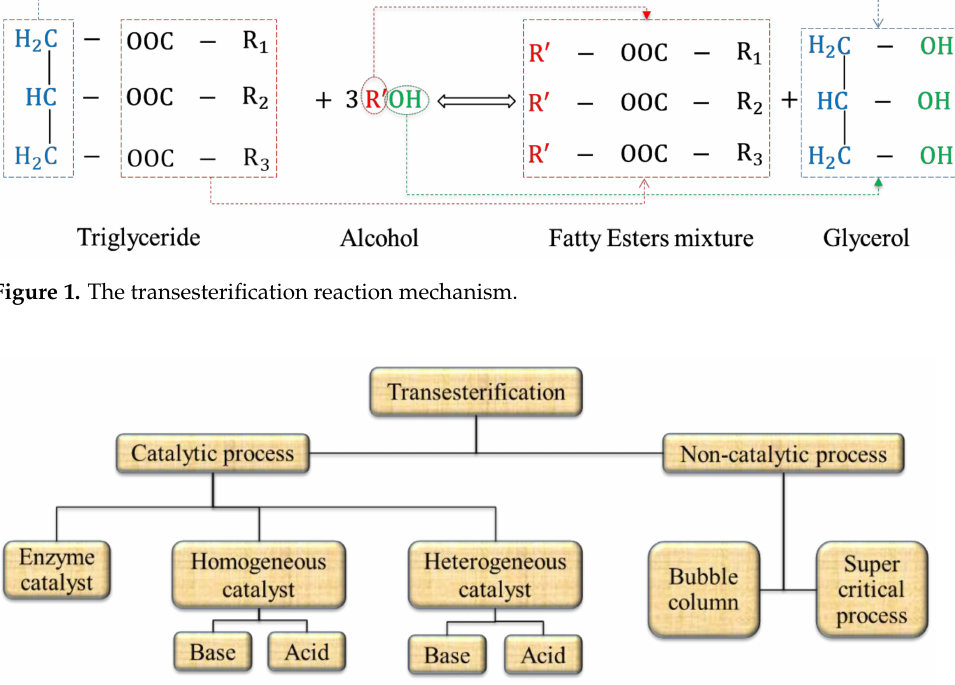
Figure 2. The transesterification